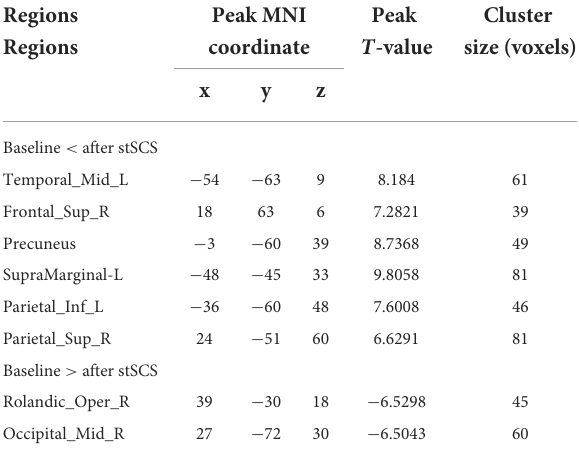
TABLE 2 Clusters of different ReHo values between baseline and after stSCS. Regions Peak MNI Peak Cluster Regions coordinate T